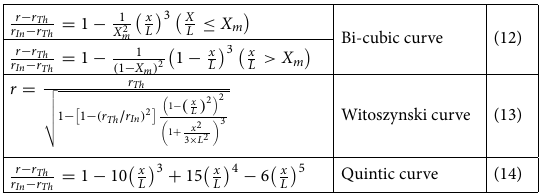
Table 2. The cubic polynomials used for designing the convergent section of nozzle 2